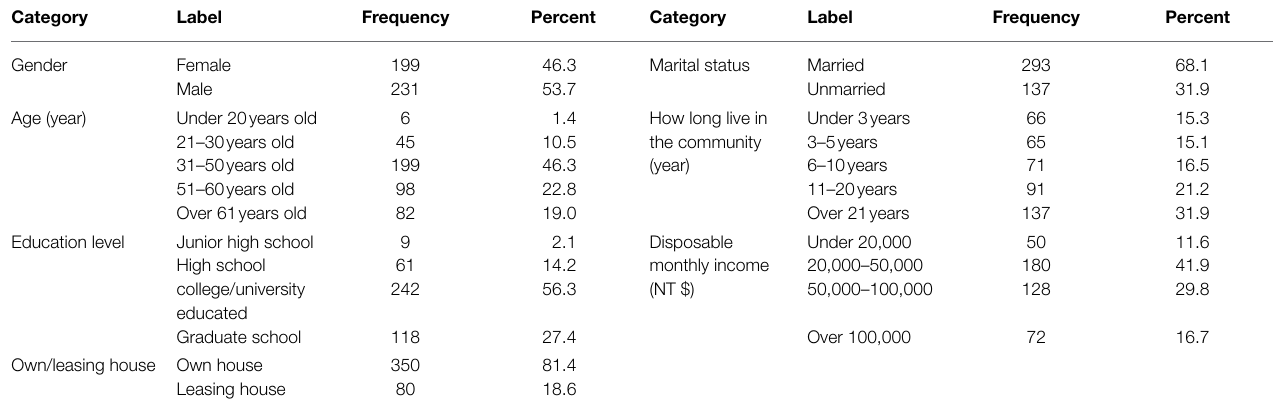
TABLE 4 | Descriptive